Question: Judging by this figure, is the value going up or going down?
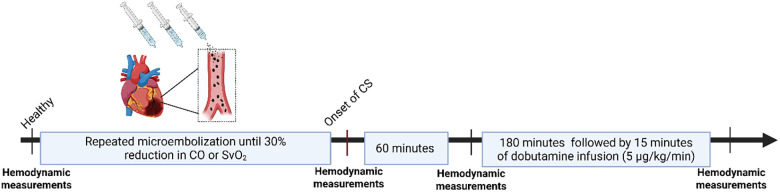
Answer: decreasing